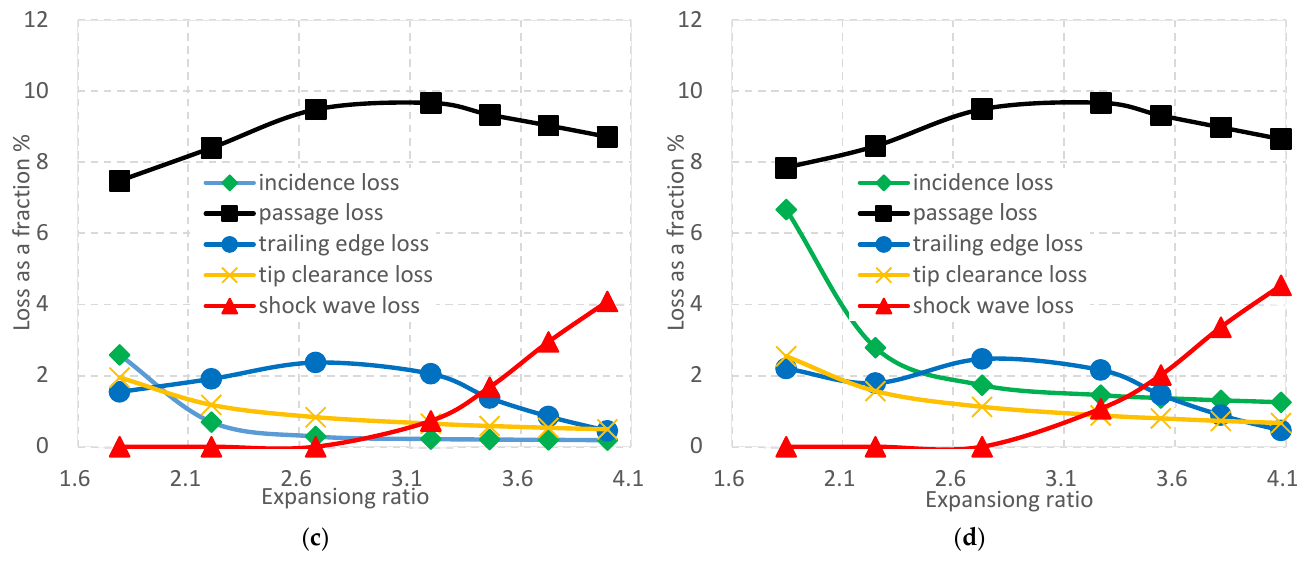
Figure 12. The distribution of different losses as fraction. ( a ) 70,000 rpm. ( b ) 80,000 rpm. ( c ) 90,000 rpm. ( d ) 100,000 rpm.